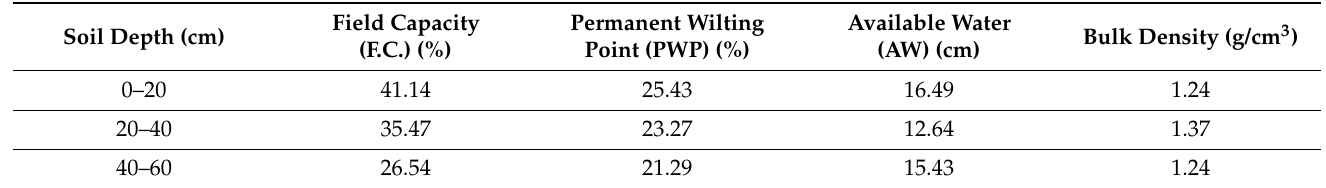
Table 1. Soil moisture contents of the experimental site on average in the 2019 and 2020 rice- growing season.